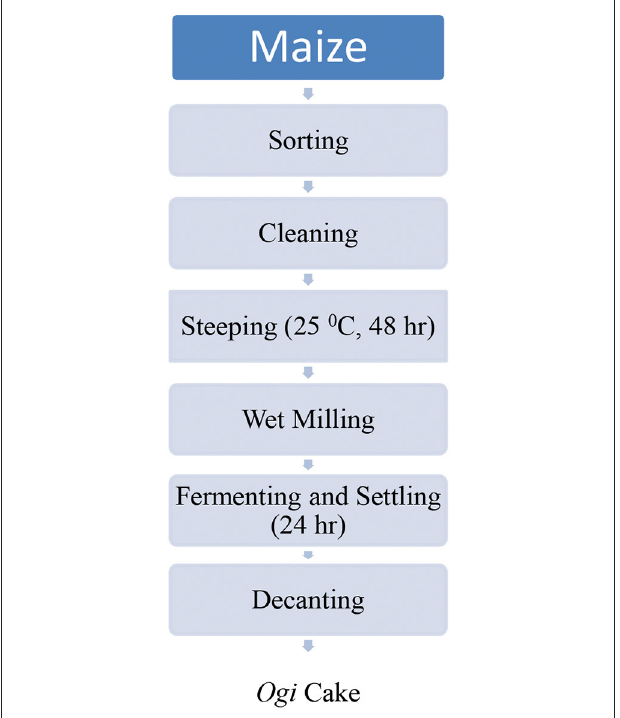
FIGURE 1 | Flow chart for the traditional production of ogi cake in Nigeria (55).